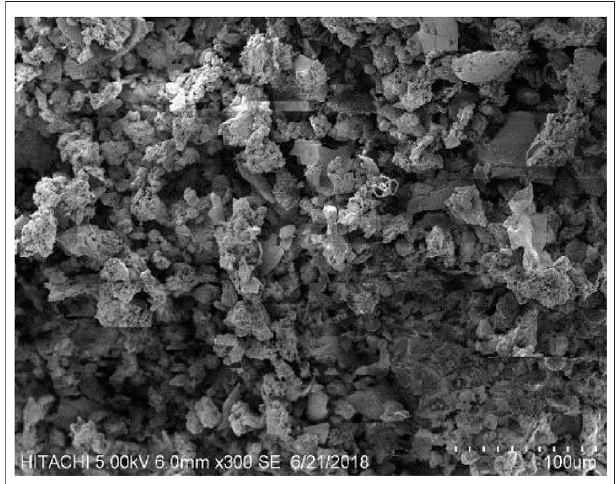
FIGURE 1 | Scanning Electron Microscopy (SEM) images of